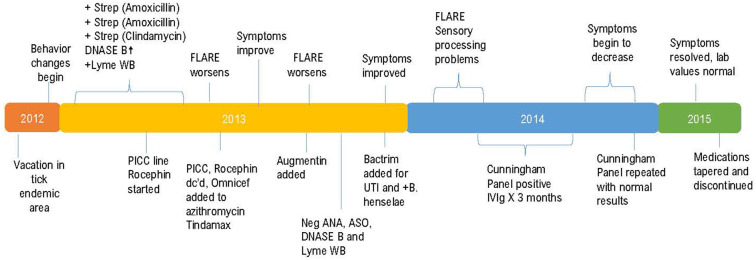
Timeline between probable disease exposure and completion of treatment.